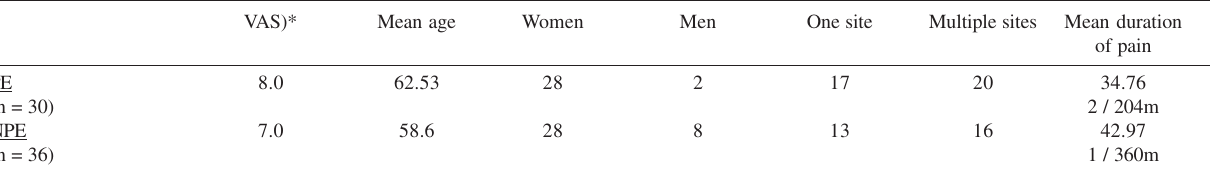
Table 3 - Intensity and distribution of pain (VAS): Precipitating (PE) and No Precipitating Events